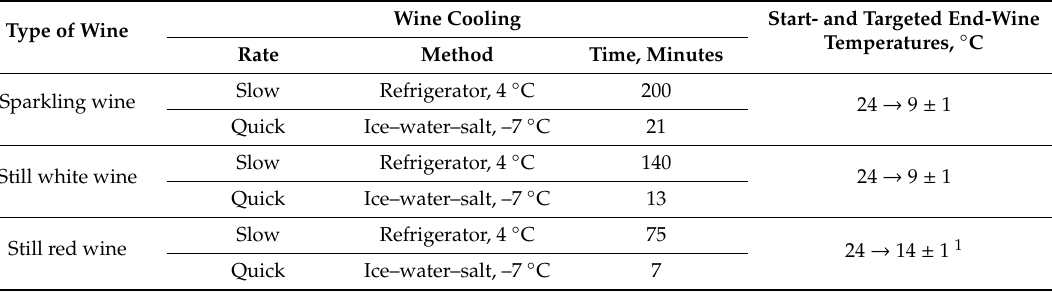
Table 2. Cooling methods of still and sparkling